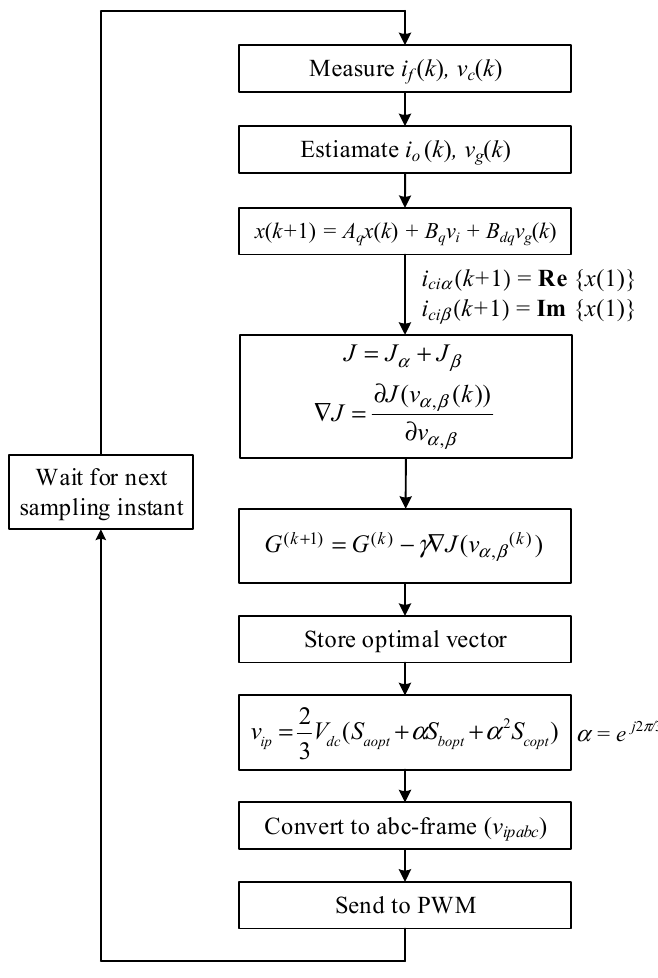
Figure 5. Flowchart of the proposed control strategy.